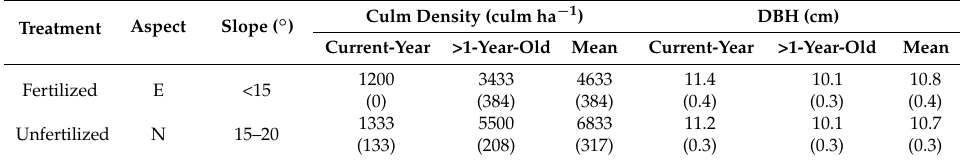
Table 1. General characteristics of the study site in a Moso bamboo stand ( n = 3).